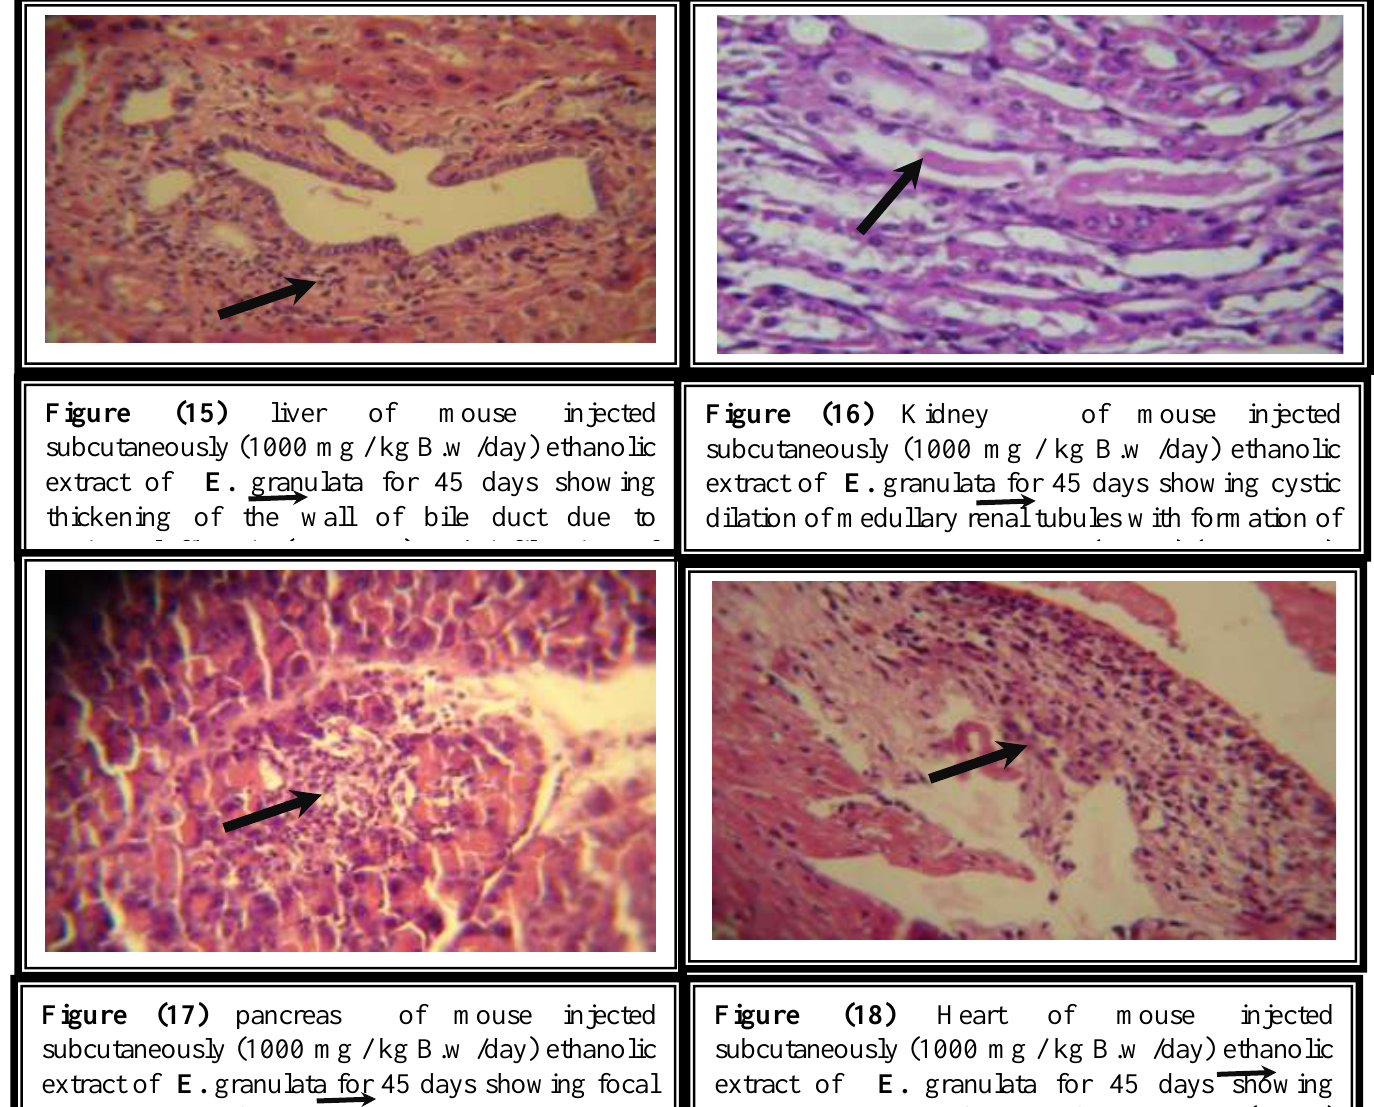
Figure (15) liver of mouse injected Figure (16) Kidney of mouse injected subcutaneously (1000 mg / kg B.w /day) ethanolic subcutaneously (1000 mg / kg B.w /day) ethanolic extract of E. granulata for 45 days showing extract of E. granulata for 45 days showing cystic thickening of the wall of bile duct due to dilation of medullary renal tubules with formation of periportal fibrosis ( ) and infiltration of hyaline cast ( ) (H&Ex400). mononuclear cells (H&Ex400).